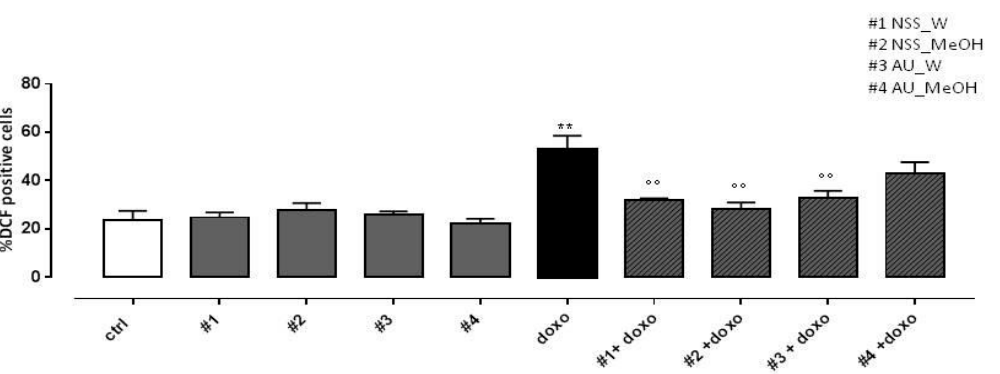
Figure 3. Effect of NSS and AU extracts on doxo-induced ROS release. NSS and AU extracts (50 μ g/mL) were administered alone for 24 h or 4 h before doxo (1 μ M). Reactive oxygen species (ROS) formation was evaluated using the probe dichlorofluorescein diacetate (H 2 DCF-DA) in H9c2 cells. ROS production was expressed as the mean ± SD of the percentage of DCF positive cells of at least three independent experiments (N = 6). Statistical analysis was performed by analysis of variance test (ANOVA), and multiple comparisons were made by Bonferroni’s test. ** p < 0.005 vs. ctrl; °° p < 0.005 and vs. doxo.